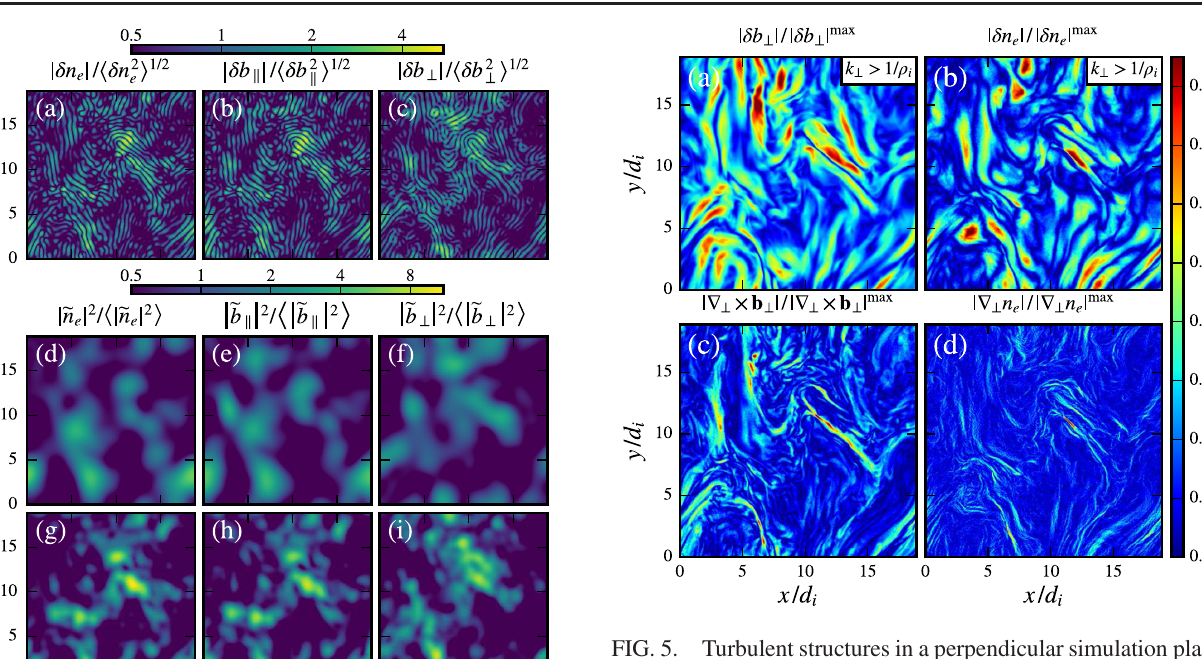
FIG. 5. Turbulent structures in a perpendicular simulation plane as seen from the perpendicular magnetic (a) and density fluctua- tions (b), and from their corresponding perpendicular gradients (c), (d). Large-scale modes with k ⊥ ≤ 1 = ρ external forcing, have been filtered out in (a) and (b) to highlight FIG. 4. Scale-filtered fluctuations in a given x - y plane in the the subion-scale structure. 5 ; 10 (cid:4) (a) – (c), and the (normalized) local wavelet range k ⊥ d i ¼ ½ 5 (d) – (f) and at scale k 10 (g) – (i). spectra at scale k ⊥ d ⊥ d i ¼ i ¼ A logarithmic scale is used to better show also the fluctuations of moderate intensity. Very weak fluctuations with amplitudes below 0.5 in the normalized units are clipped to the lower boundary of the color map.